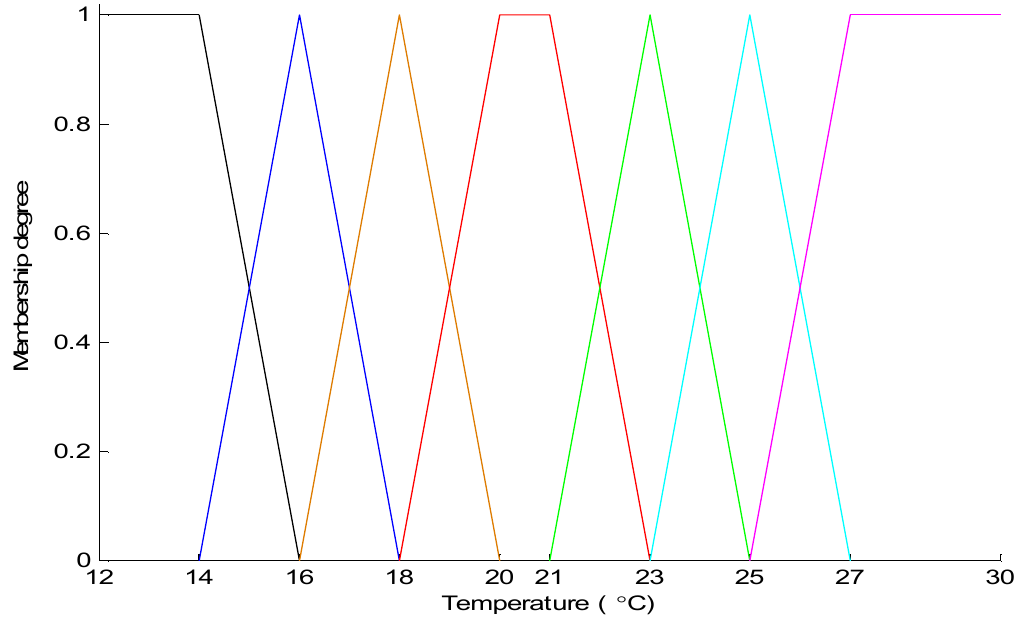
Figure B1. Temperature membership functions in